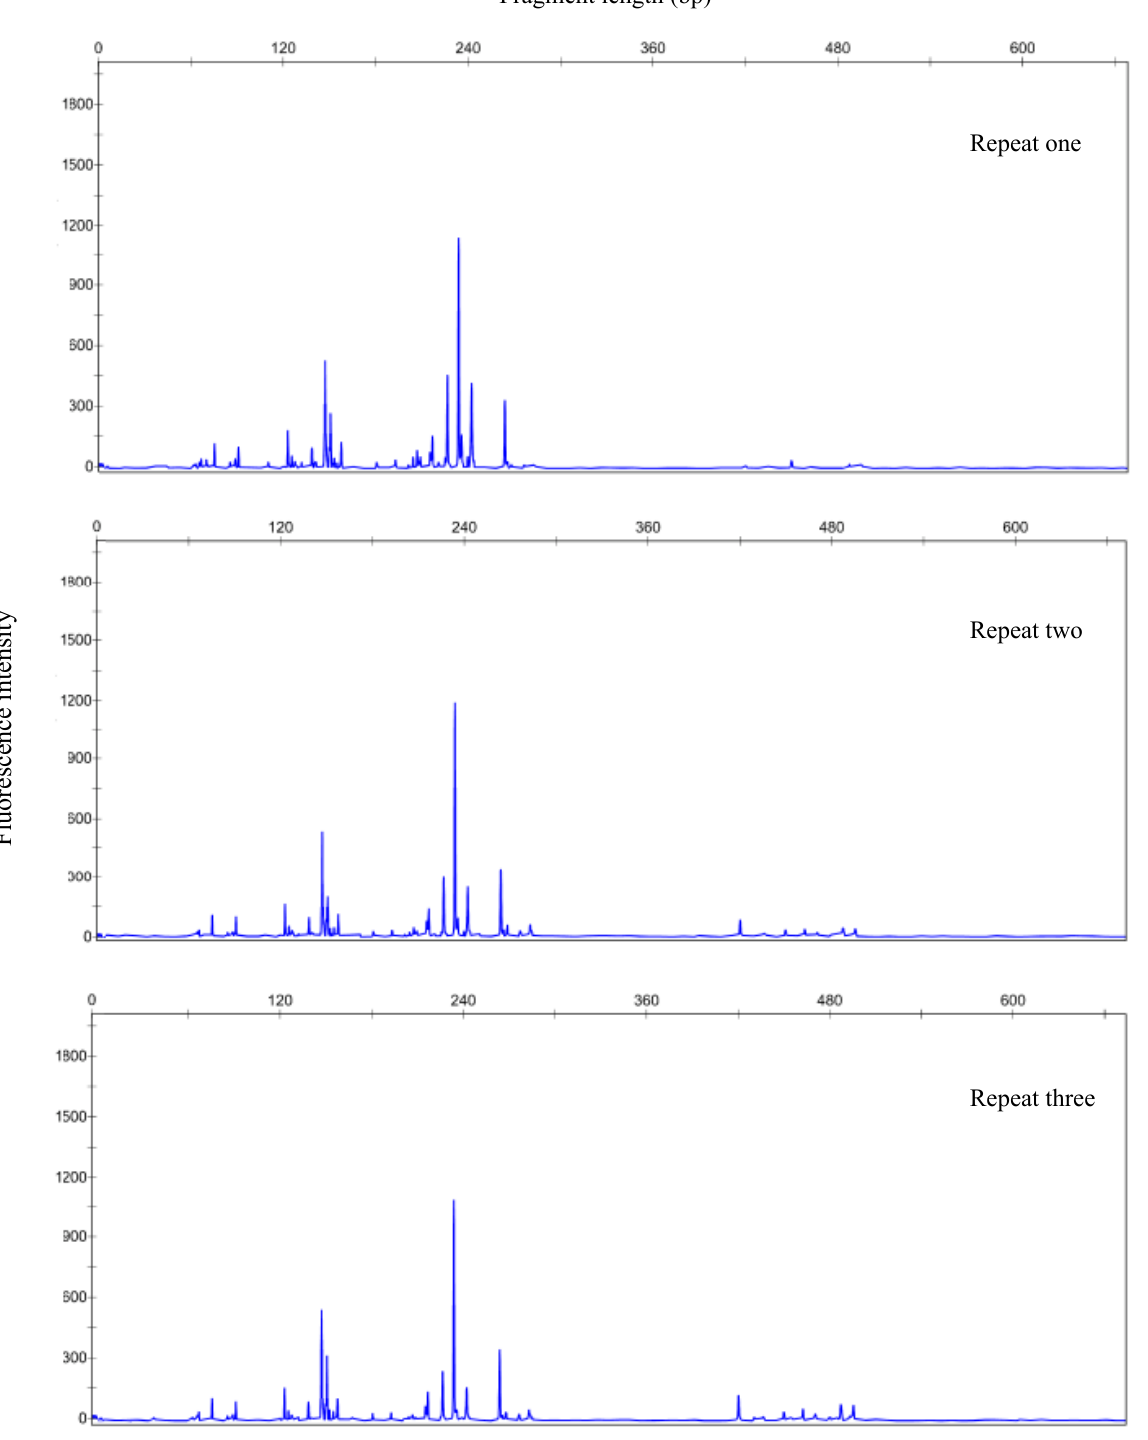
Fig. S4: T-RFLP chromatogram of fungi in rhizosphere soil of tea tree with pH value